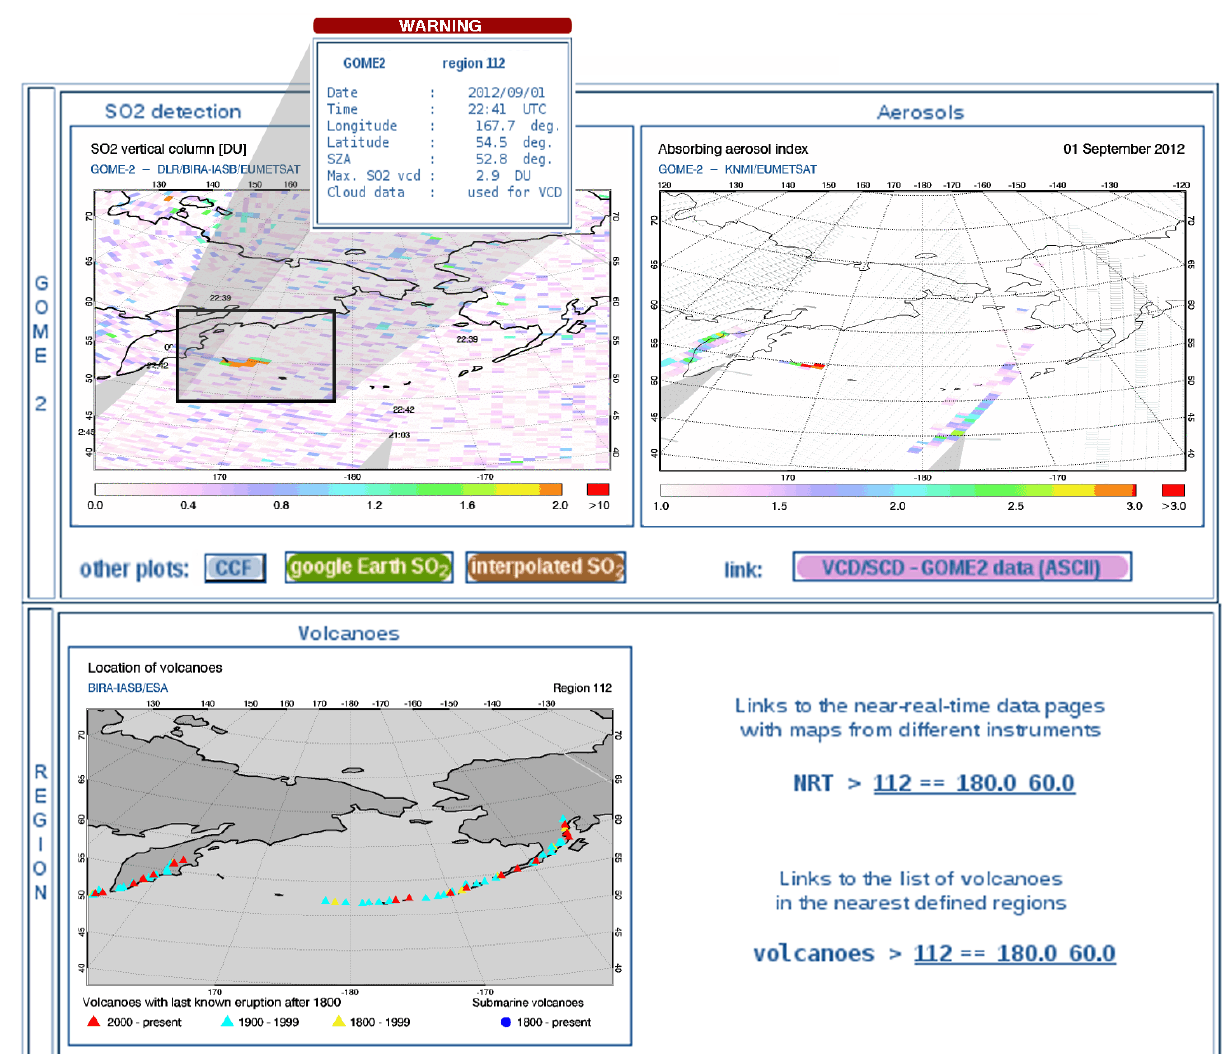
Fig. 11. SO 2 and aerosol images from GOME-2A (notification web page), 1 September 2012 (eruption of the Bezymianny Volcano in the Kuril